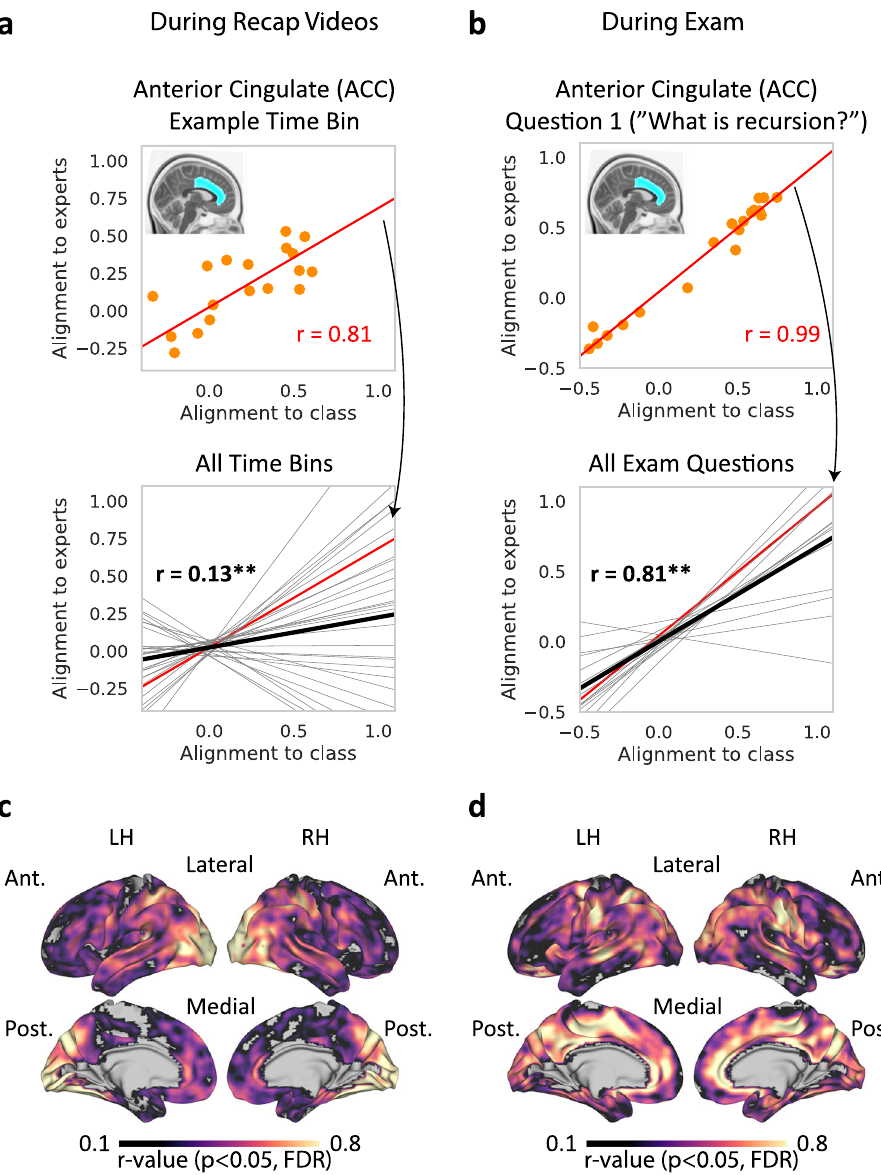
Fig. 3 Alignment-to-class and alignment-to-experts are positively correlated across the brain. Correlation between alignment-to-class and alignment-to- expert during recap videos (left) and during fi nal exam (right) are shown. a Between-subjects correlation during recap videos, in a single ROI. Top, correlation in a single example 30-s time bin. Orange dots represent individual students. Bottom, mean across all time bins (solid black line). Trendlines for individual time bins are shown in gray, with the example time bin shown in red. Asterisks denote signi fi cant correlation (one-sided permutation test, corrected), * p < 0.05, ** p < 0.01. b Between-subjects correlation during the fi nal exam, in a single ROI. Top, correlation during the fi rst question. Orange dots represent individual students. Bottom, mean across all exam questions (solid black line). Trendlines for individual questions are shown in gray, with the example question shown in red. Asterisks denote signi fi cant correlation (one-sided permutation test, p < 0.01, corrected). See Table 3 for a summary of ROI analysis results. c Correlation during recap videos across the cortex, searchlight analysis results are shown. Voxels showing signi fi cant correlation are shown in color (one-sided permutation test, p < 0.05, corrected). d Correlation during the fi nal exam across the cortex. Voxels showing signi fi cant correlation are shown in color (one-sided permutation test, p < 0.05, corrected). LH left hemisphere, RH right hemisphere, Ant. anterior, Post.